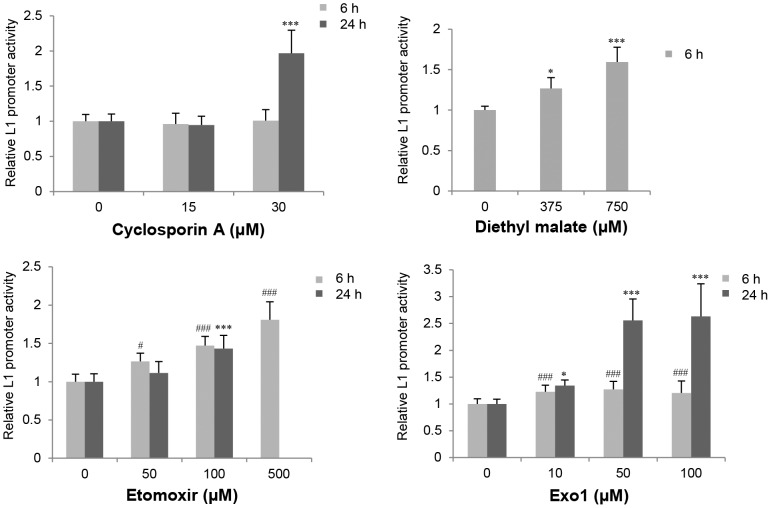
Effects of cellular stress induced by chemicals on L1 promoter activity in HepG2 cells.L1 promoter activity 6 and 24 hours after treatment was evaluated by the luciferase reporter gene assay. Data are represented as the average ratio (± SD) of the L1 promoter activity in the presence of the test compound relative to that in the presence of the vehicle control from at least three independent experiments (in duplicate; n = 6 or more) in the case of cyclosporin A, two independent experiments (in duplicate; n = 4) in the case of etomoxir and diethyl malate, and at least four independent experiments (in duplicate; n = 8 or more) in the case of exo1. The experimental data using diethyl malate and 500 µM etomoxir are shown only after 6 hours because of overt cytotoxicity after a 24-hour exposure (data not shown). Statistically significant differences as compared with the vehicle control for 6-hour and 24-hour treatments are indicated by *and #, respectively (*or #, p<0.05; ***or ###, p<0.001).